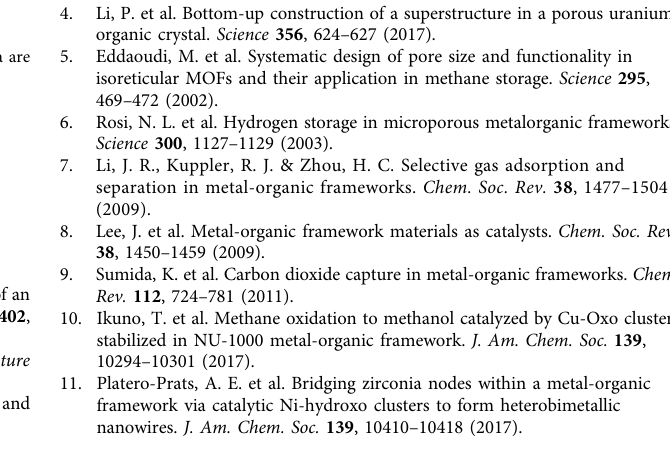
Data availability The authors declare that all relevant data supporting the fi ndings of this study are available within the paper and its Supplementary Information fi les. Additional data are available from the corresponding authors upon reasonable request.